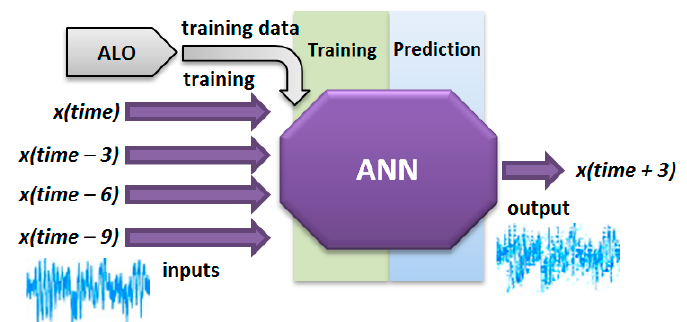
Figure 3. Brief scheme of the artificial neural network (ANN) and ant-lion optimizer (ALO) hybrid system (ANN–ALO) for chaotic electroencephalogram (EEG) prediction.